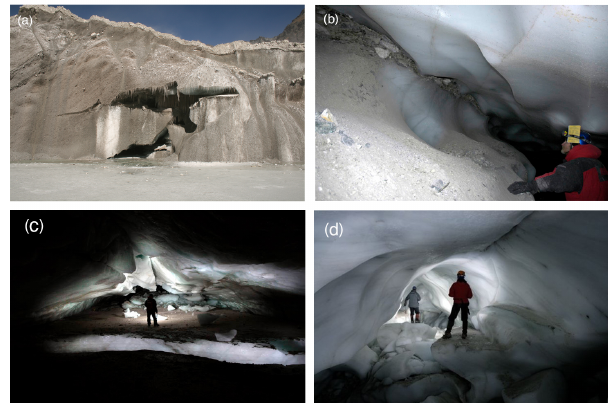
Figure 7. (a) The entrance of NG-05 on the NW margin of Spillway Lake; (b) NG-01: debris-filled canyon suture at the upper level of the cave; (c) NG-01: flat-floored mid-level of the cave (note canyon suture above and incised lower level crossing foreground from left to right); (d) NG-02: tubular upper passage with canyon suture in the